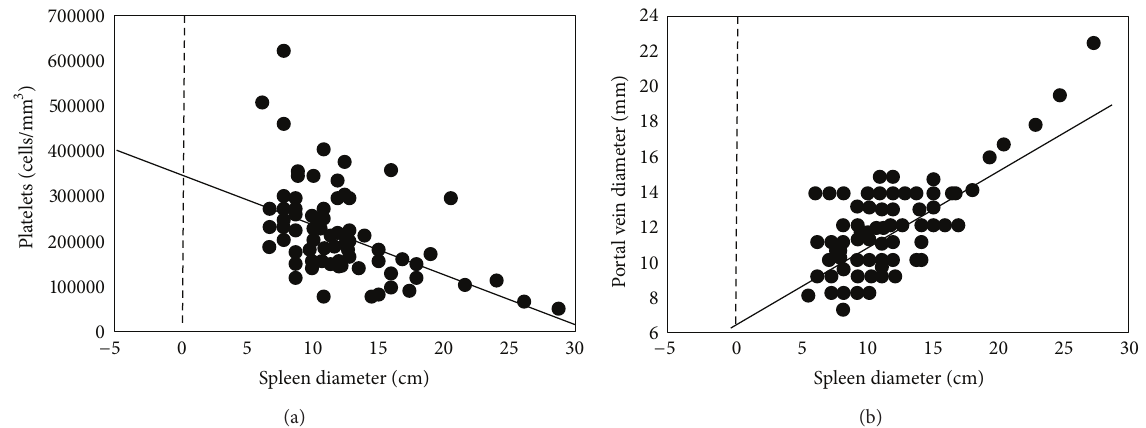
Figure 1: Spleen diameter, portal vein diameter, and platelets count in the 117 PAD patients. Regression analysis showed the correlation between spleen diameter and platelets counts and between spleen and portal vein